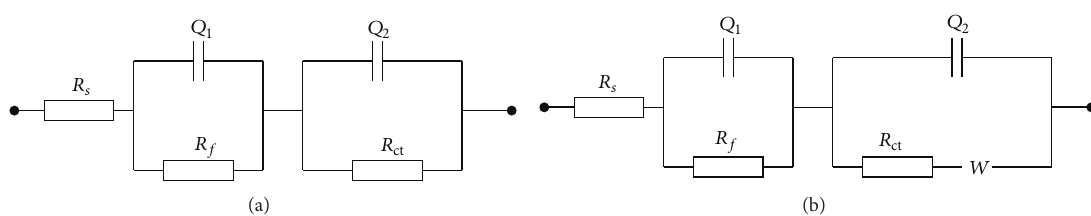
Figure 6: Two equivalent circuit models used to fit the experiment impedance data of galvanized steel in SRL solution.